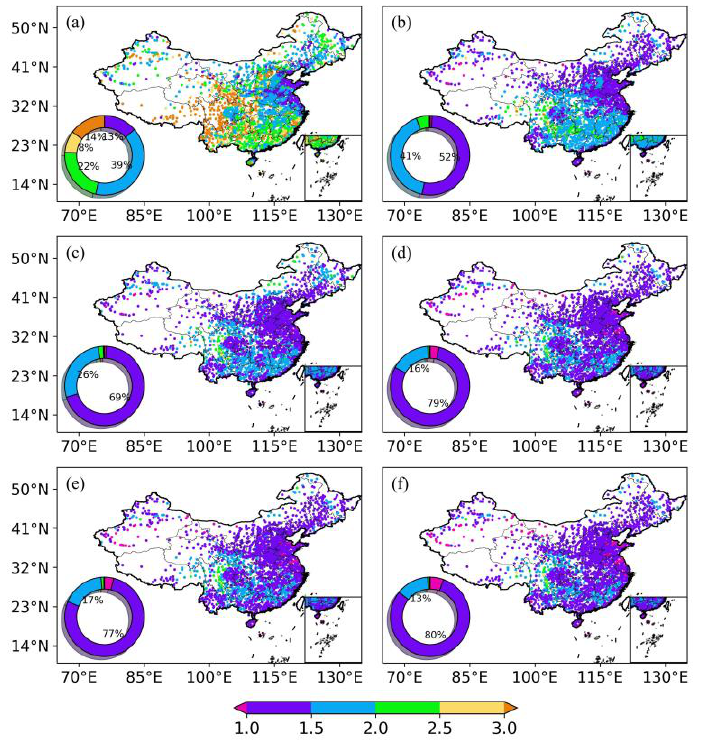
Figure 6. Spatial distributions of average RMSE of daily maximum air temperature forecasts at all stations using different neural work models and the ECMWF-IFS model (unit: ◦ C; the ring chart in the lower left corner represents the proportion of the number of stations (less than 6% are not shown) with different RMSE interval values to the total number of stations). ( a ) ECMWF-IFS, ( b ) DA, ( c ) ED-FCNN, ( d ) LSTM, ( e ) TCN and ( f )